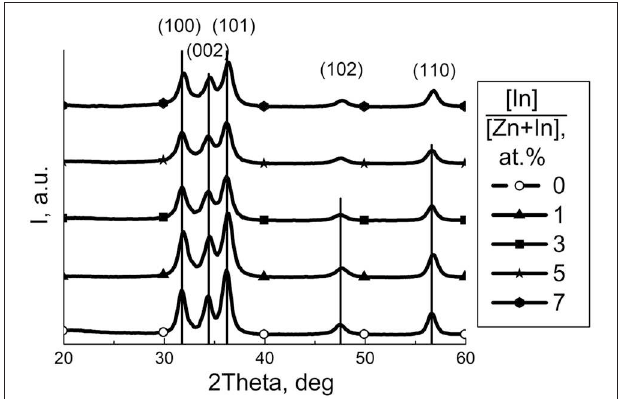
FIGURE 1 | XRD patterns of zinc oxide modified by different amount of In 2 O 3 . Peaks are indexed for wurtzite ZnO phase (JCPDS 36-1451).